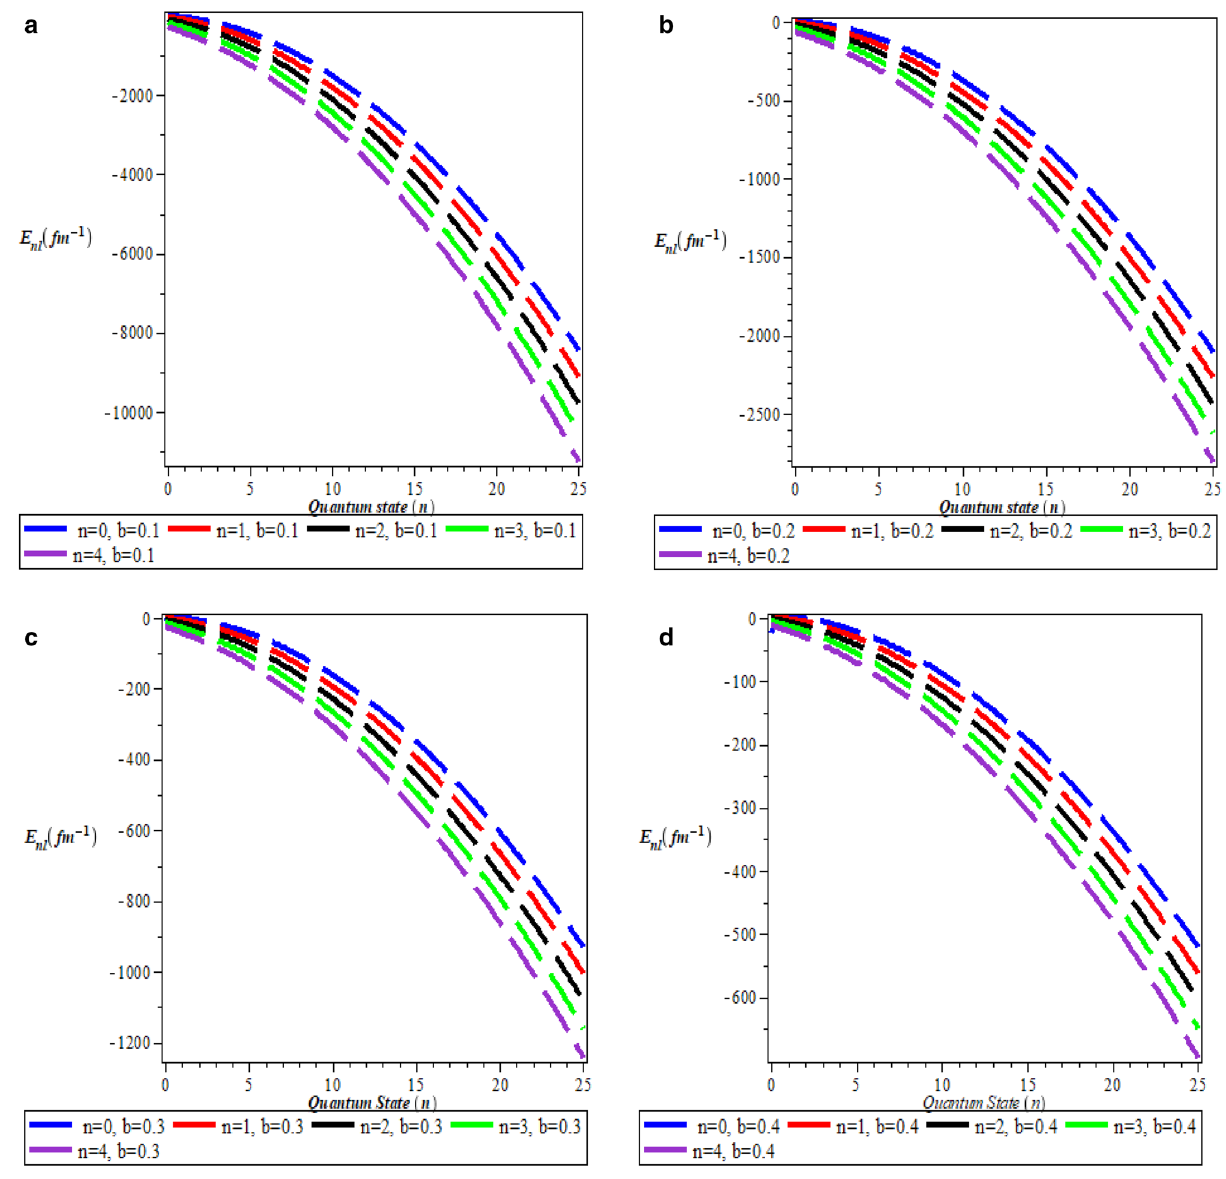
Figure 5. ( a ) Nonrelativistic energy spectra for b = 0.1 . ( b ) Nonrelativistic energy spectra for b = 0.2 . ( c ) Nonrelativistic energy spectra for b = 0.3 . ( d ) Nonrelativistic energy spectra for b = 0.4